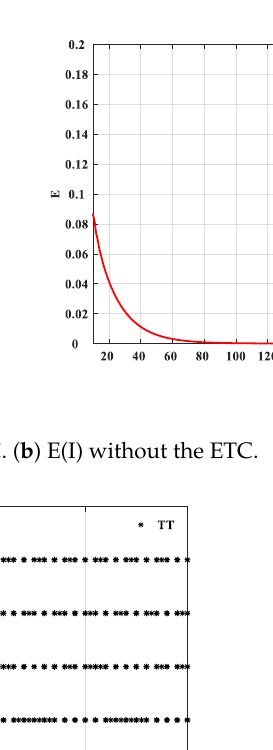
Figure 5. ( a ) E(I) with the ETC. ( b ) E(I) without the ETC.